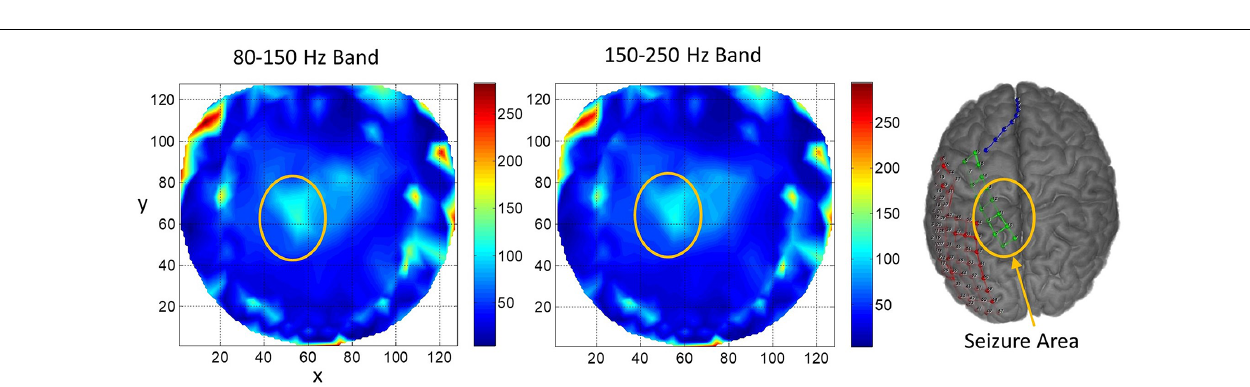
FIGURE 3 | The rate of formation (counts/s) of stable phase cone clusters averaged over a 240-s interictal period for subject #1 in the 80–150 Hz and 150–250 Hz bands are given in the left and middle plots, respectively. The color bar indicates the rate in counts/s. (Right plot) The grid layout for electrocorticograms (ECoG) data collection with red ellipse showing the area where seizures and epileptogenic activities were observed.